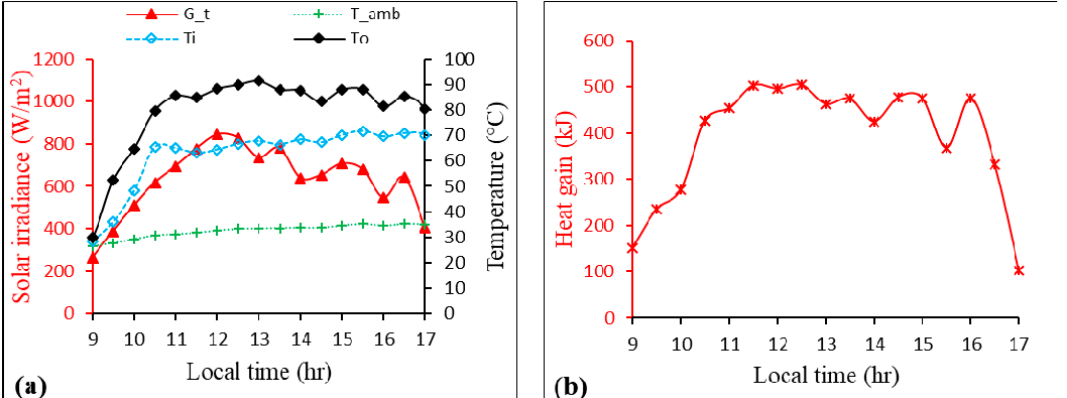
Figure 14. Experimental results of CPC collector with CT receiver: ( a ) solar irradiance and temperatures and ( b ) heat gain for E-W installation recorded on 12 th Apr 2019.